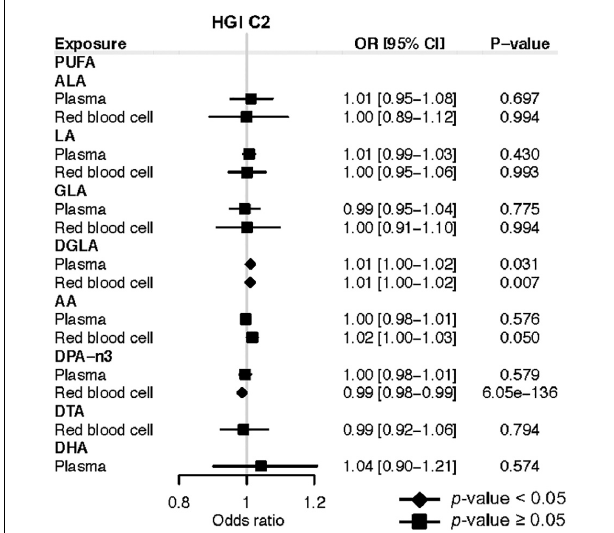
FIGURE 3 | Mendelian randomization estimates of the effects of polyunsaturated fatty acids on COVID-19 susceptibility risk based on the release 5 HGI C2. Odds ratios are scaled to a genetically predicted SD increase in polyunsaturated fatty acids. Associations with p -value < 0.05 were indicated with diamonds, while others with squares. Detailed summary statistics are available in Supplementary Table 9 . PUFA, polyunsaturated fatty acid; ALA, α -Linolenic acid; LA, linoleic acid; GLA, γ -linoleic acid; DGLA, dihomo- γ -linoleic acid; AA, arachidonic acid; DPA-n3, docosapentaenoic acid; DTA, docosatetraenoic acid; DHA, docosahexaenoic acid; OR, odds